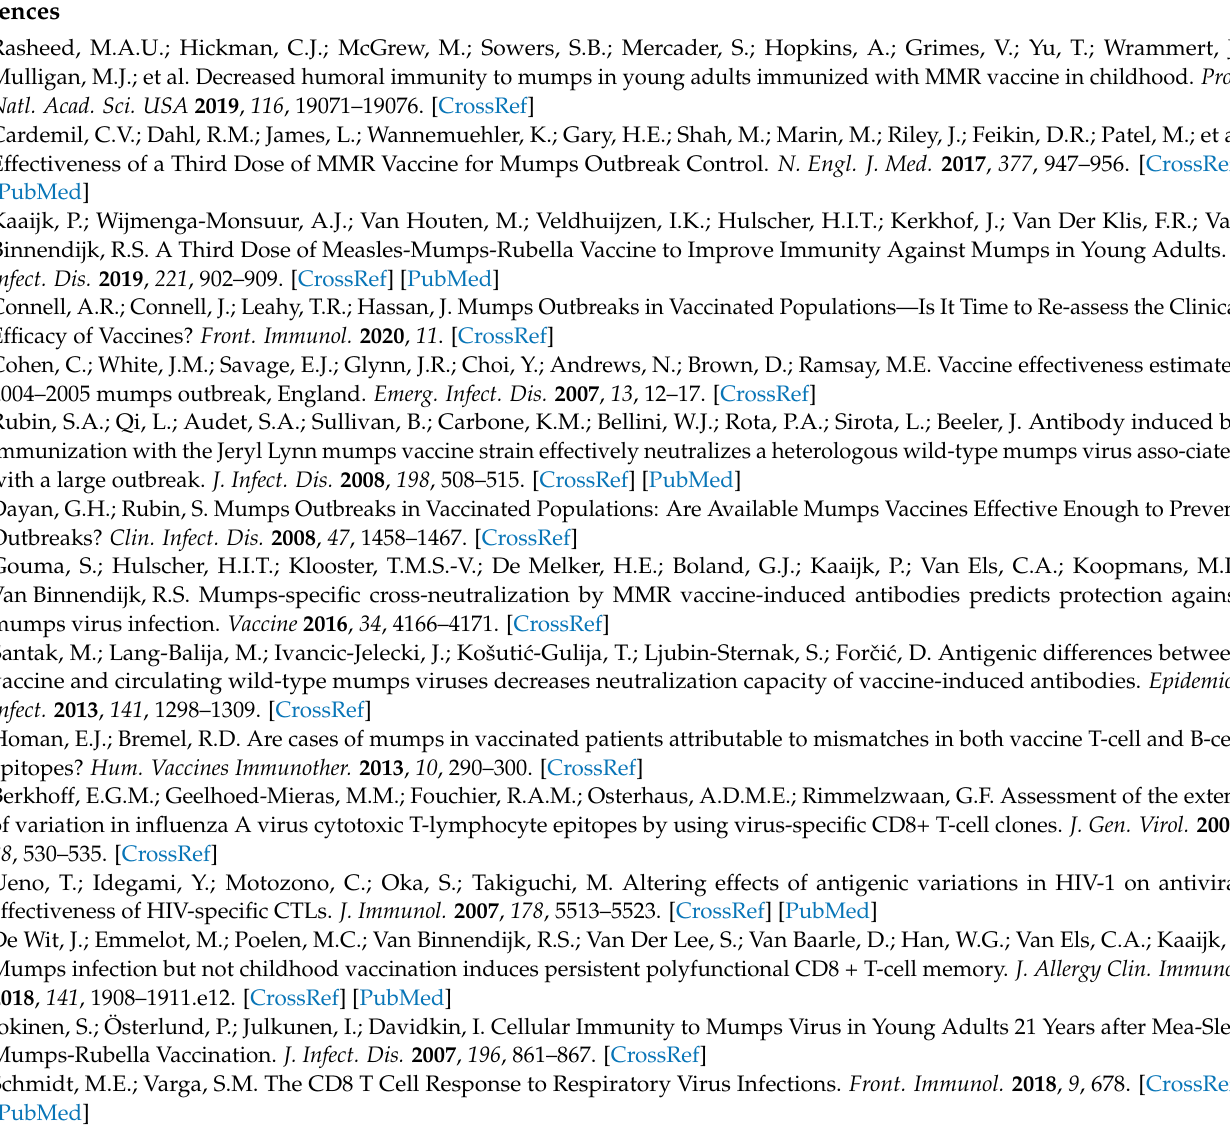
Table S3: can be found as Excel Worksheet 3. List of epitope variants with reduced binding compared to the JL2/5 vaccine